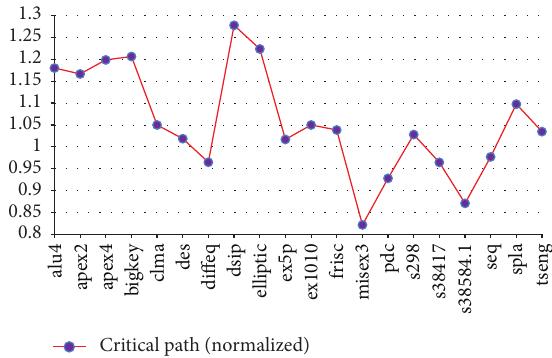
Figure 6: Comparative results of critical path for diffusion based placement algorithm using average approach normalized to the respective results from VPRs placement algorithm for cluster size 𝑁 = 4 .